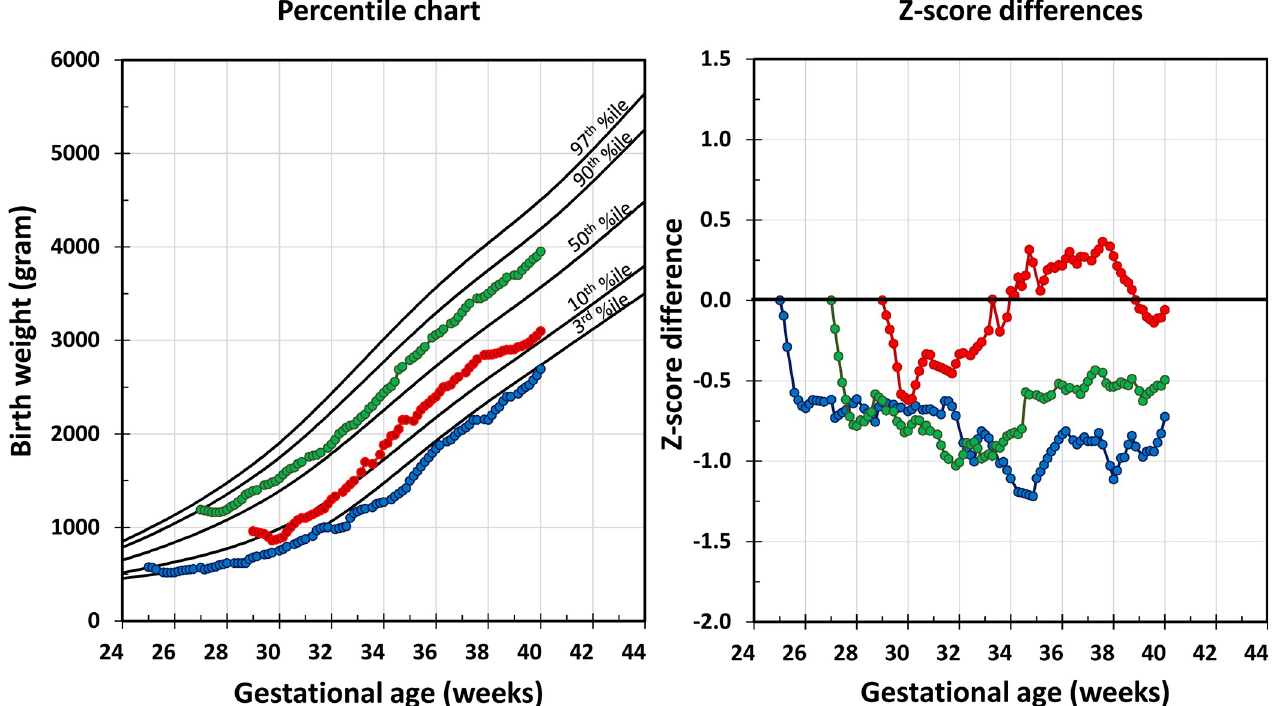
Fig 1. Common tools for the assessment of growth: percentile charts (left panel) and z-score plots (right panel), modified from Fenton et al. 2013 and Griffin et al. 2014; colored lines and dots represent growth trajectories of three example infants.